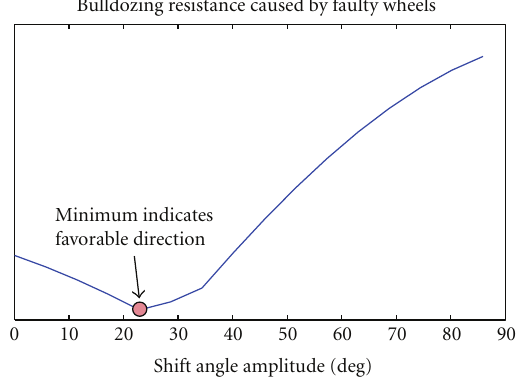
Figure 13: Bulldozing resistance force as a function of di ff erent shift angles to the crab mode.